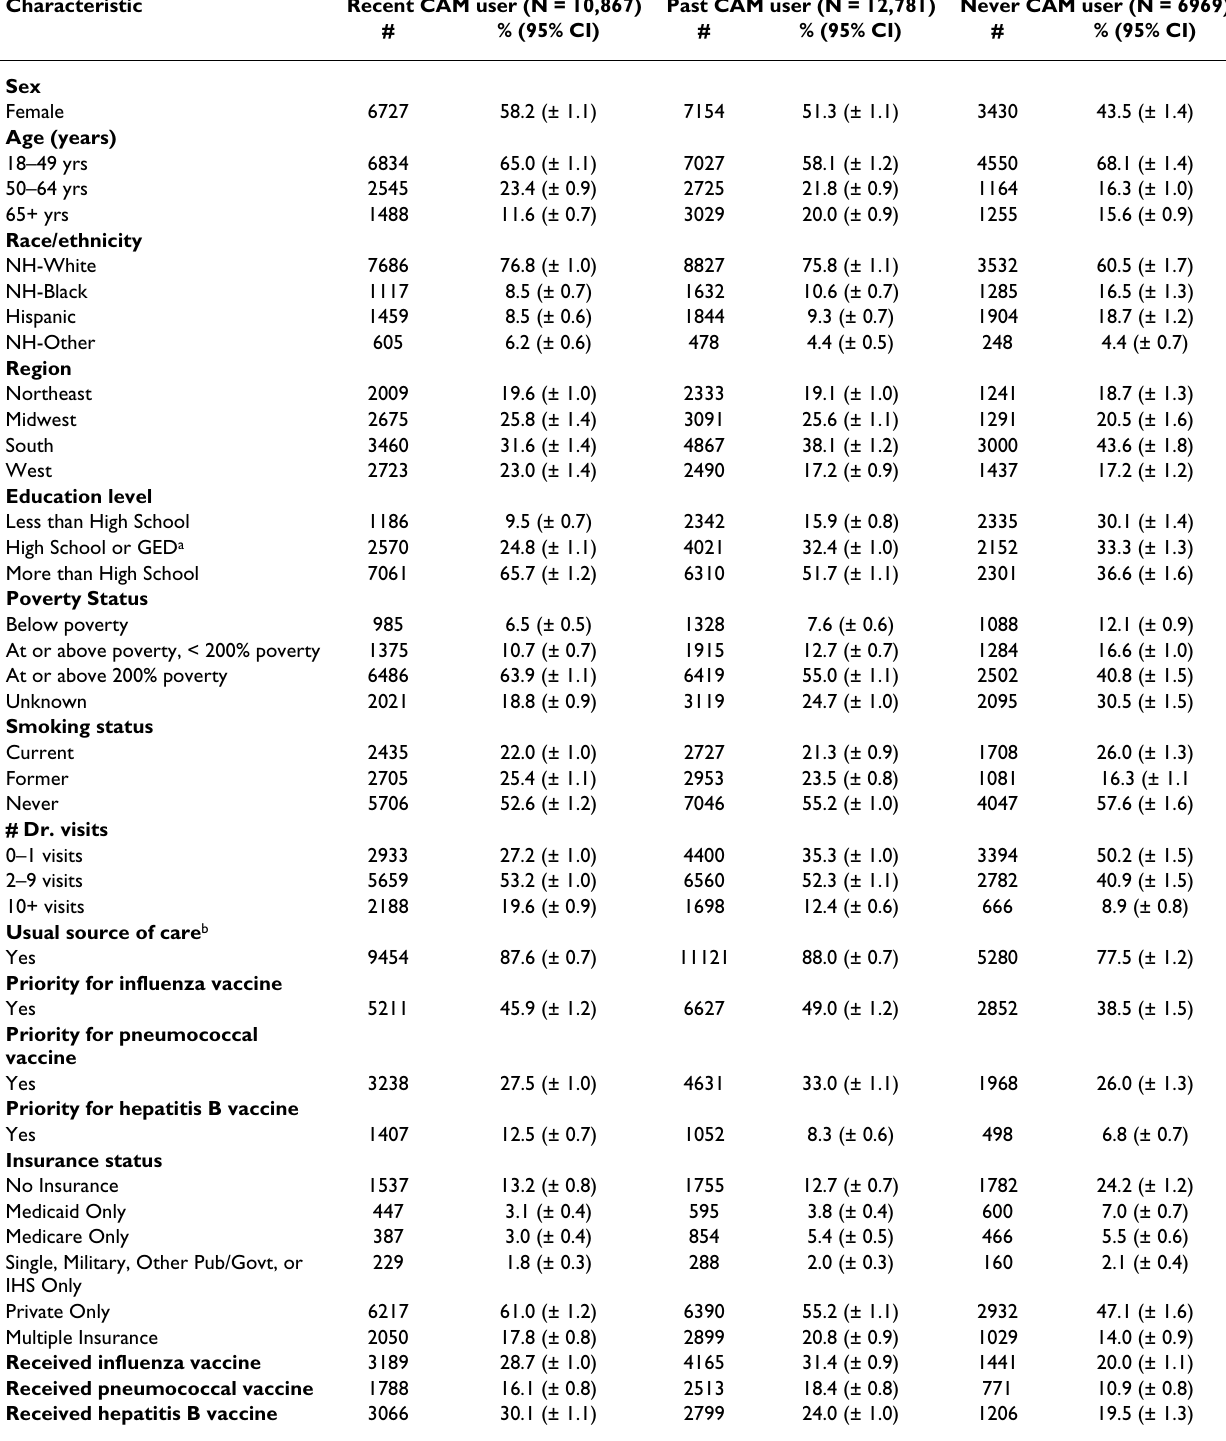
Table 2: Demographic characteristics and vaccination status by Complementary/Alternative Medicine (CAM) use, 2002 National Health Interview Survey